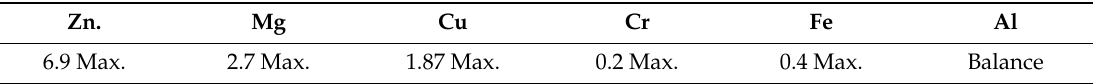
Table 1. Chemical composition by weight (%) of aluminum alloy 7075-T6.